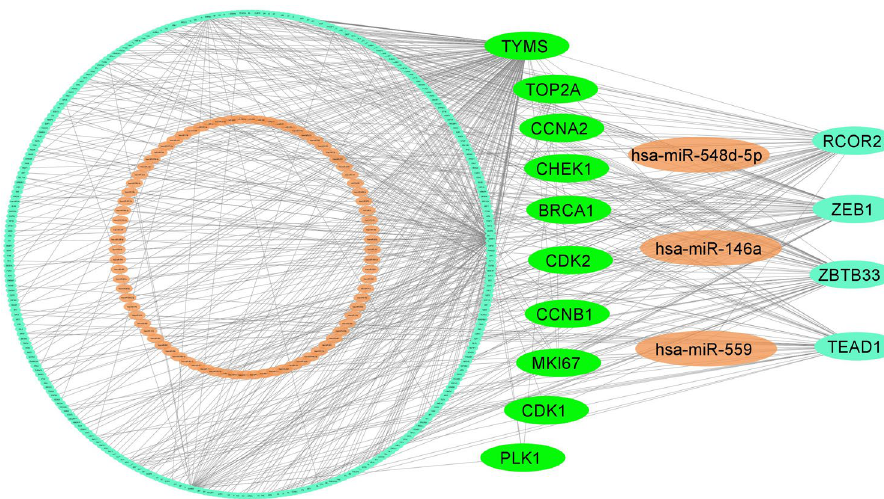
Fig. 4 TFs-genes- miRNAs interaction network with hHubGs. The highlighted green color nodes represent the hHubGs, orange color nodes represent the miRNAs, and other cyan color nodes represent TFs. The network consists of 400 nodes and 583